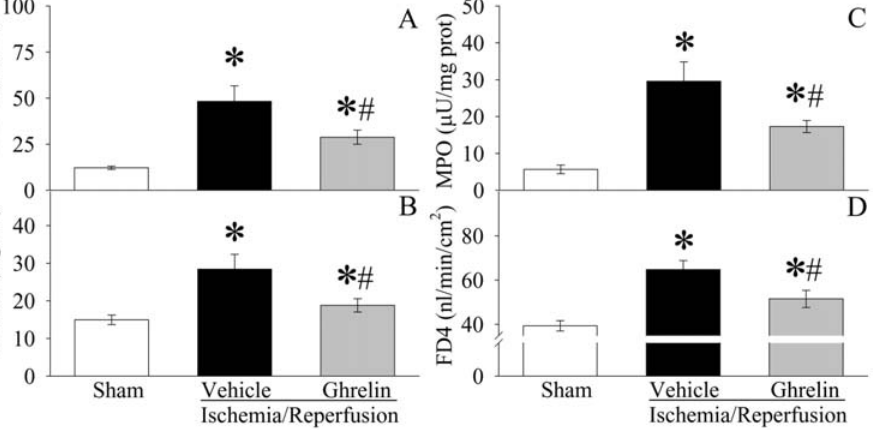
Figure 10. Alterations in serum levels of TNF- a (A) and lactate (B), intestinal MPO activities (C), and intestinal mucosal permeability (D) to fluorescein isothiocyanate dextran with a molecular weight of 4000 Da (FD4) in sham-operated animals (Sham) and ischemia/reperfusion animals treated with intracerebroventricular (ICV) injection of normal saline (Vehicle) or ghrelin (Ghrelin) at 1.5 h after the completion of treatment (i.e., 2 h after reperfusion). Data are presented as means 6 SE (n=6) and compared by one-way ANOVA and Student-Newman-Keuls test: * P , 0.05 versus Sham group; # P , 0.05 versus Vehicle group.